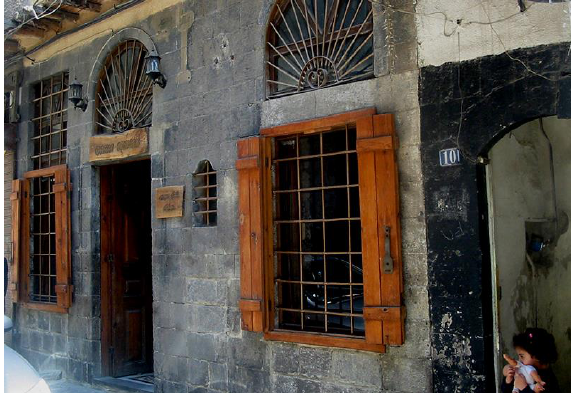
Figure 9. Antique shop, R.Aboukhater, April, 2010.